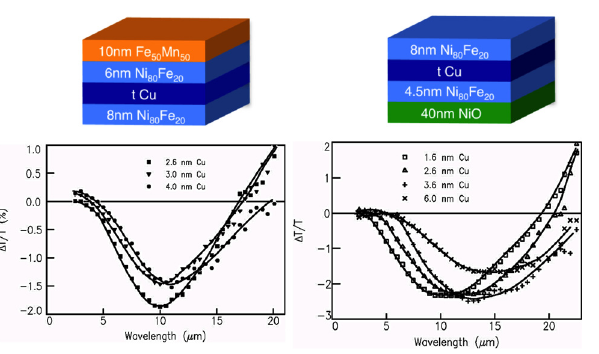
Figure 6: MRE in two Ni 80 Fe 20 based types of spin valves.MRE spectra ( Δ T/T=(T AP -T P )/T p ) of unpolarized light at normal incidence of the spin valves schematically represented on the top part of the fi gure for different values of the Cu layer thickness. The lines are guides to the eye. From ref [60], https://doi.org/10.1103/PhysRevB. 61.15321, with permission.